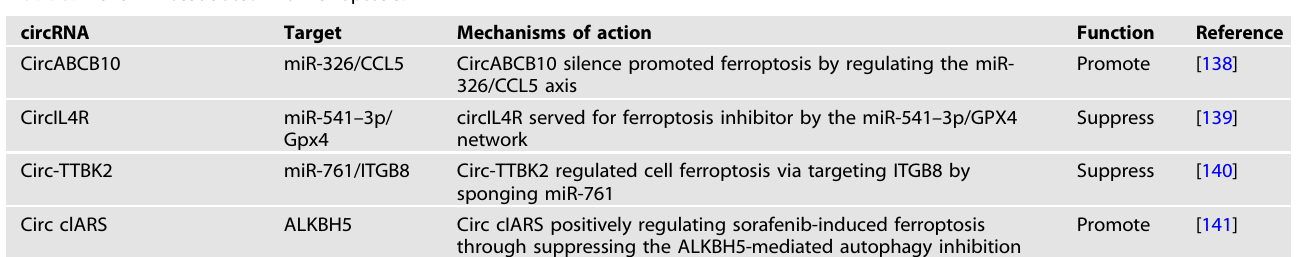
Table 3. circRNA associated with